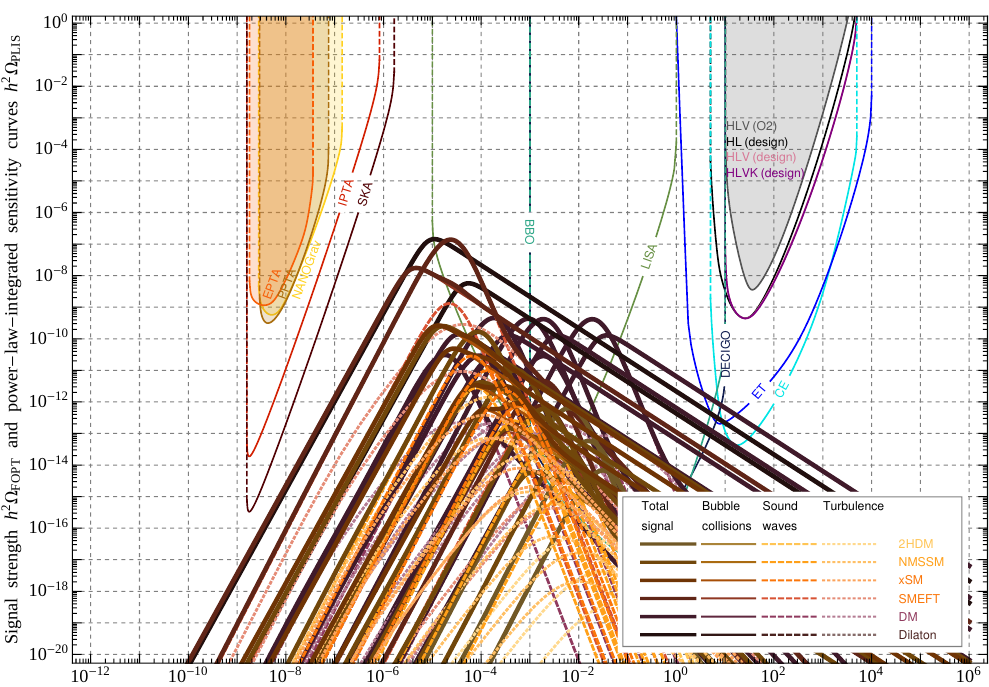
Figure 3 . PLISCs and GW signals for all benchmark points listed in table